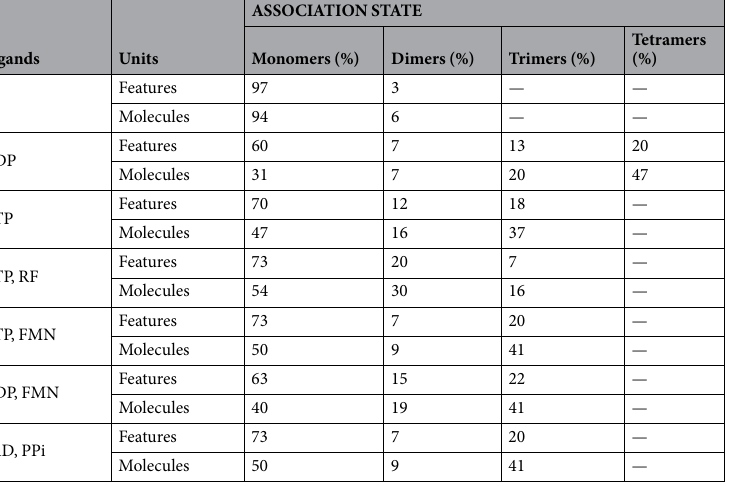
Table 3. Percentages of Spn FADS assemblies imaged by AFM. Samples of 0.5 μ M Spn FADS were analyzed in